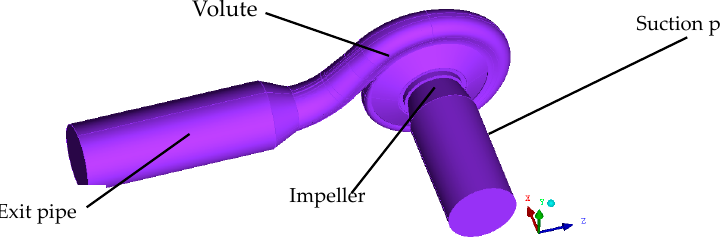
Figure 5. Physical model of the centrifugal pump. Table 2. Geometric parameters of the impeller and volute